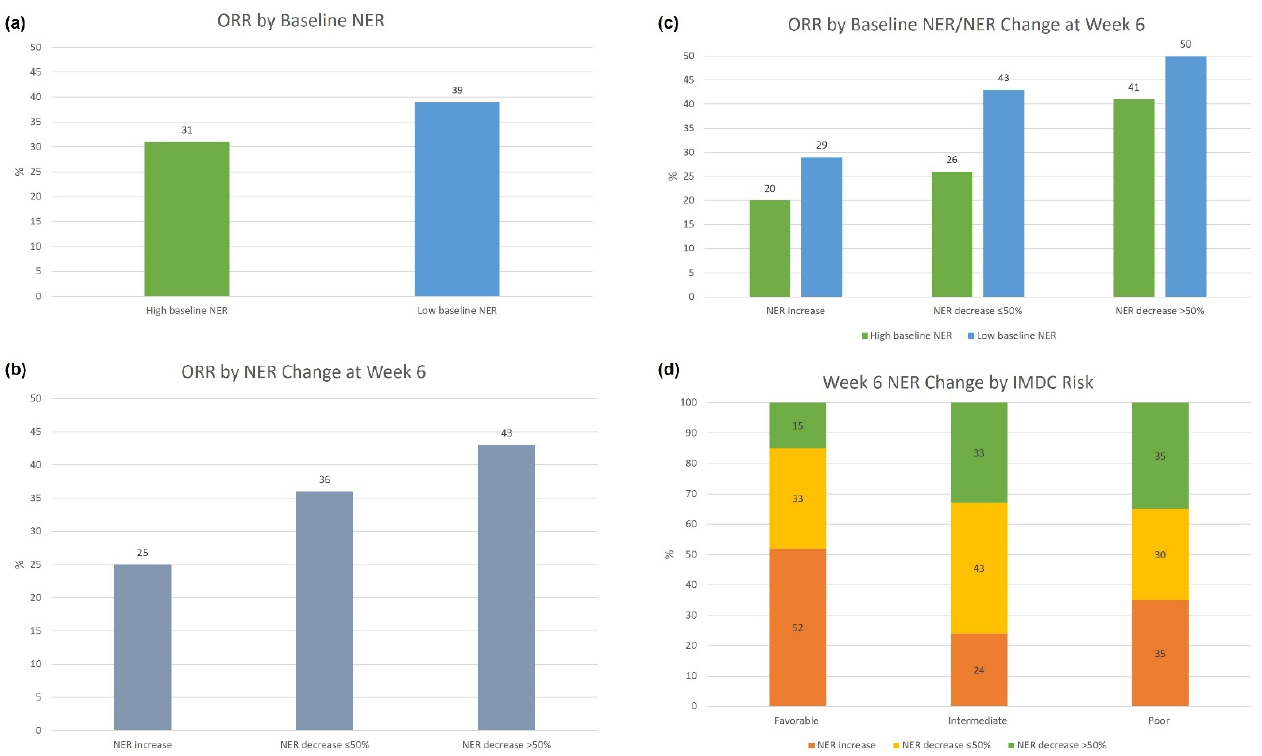
Figure 2. ORR by baseline NER and NER change at week 6.